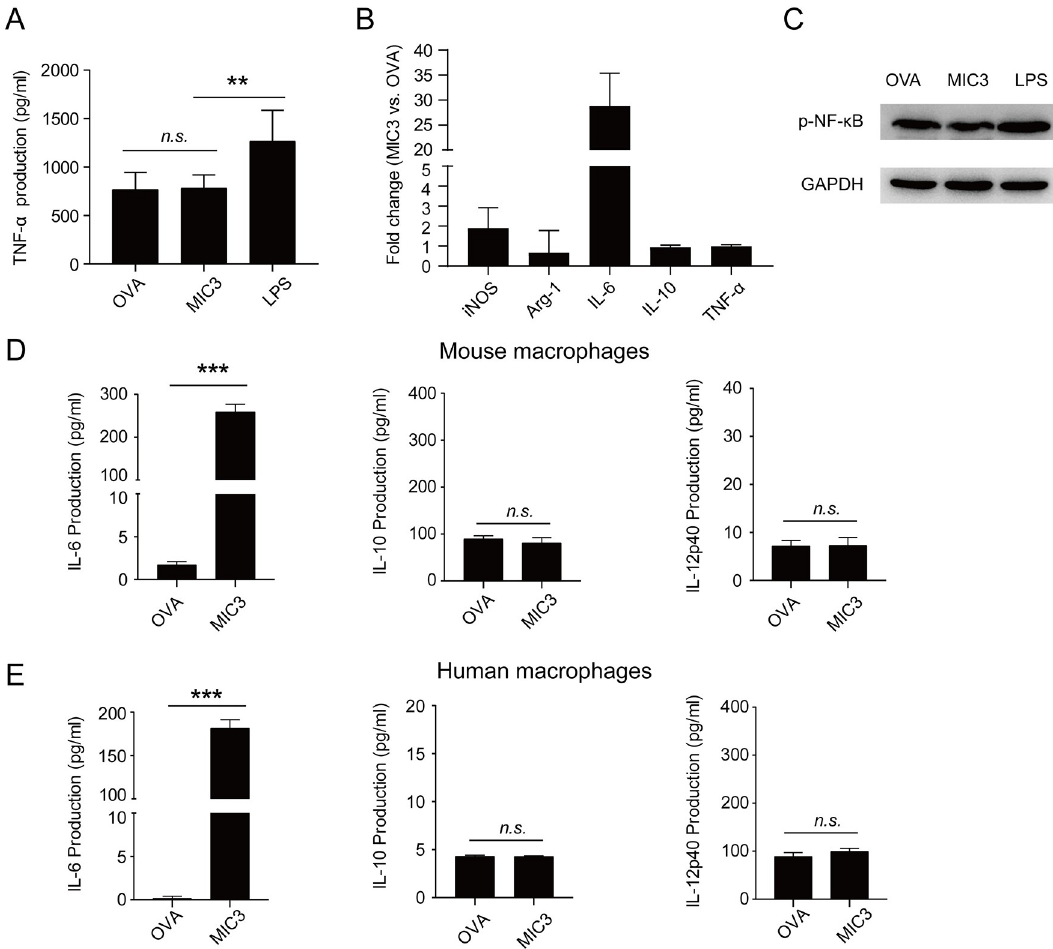
Fig 6. MIC3-induced innate immune responses in THP-1 derived macrophages and cytokine responses in RAW264.7 cells. (A) The levels of TNF- α secreted by THP-1 derived macrophages after 24 h-treatment of MIC3. THP-1 cells were incubated with PMA to differentiate into THP-1 derived macrophages. Then 4 μ g/ml OVA, 4 μ g/ml MIC3 and 1 μ g/ml LPS were added into the culture medium respectively. The levels of TNF- α were evaluated by ELISA. Data are expressed as the means ± S.D. of six independent samples for each group. Significance was determined by one-way ANOVA. �� , P < 0.01. n . s ., P > 0.05. (B) The mRNA levels of polarization and inflammation-related genes after 24 h-treatment of MIC3 in THP-1 derived macrophages. Data are expressed as the means ± S.D. of three independent samples for each group. (C) NF- κ B p65 phosphorylation of THP-1 derived macrophages after the treatment of MIC3. The NF- κ B p65 phosphorylation of THP-1 derived macrophages after 24 h-treatment of 4 μ g/ml MIC3, 4 μ g/ml OVA and 1 μ g/ml LPS was detected by Western blotting. (D) Cytokines secreted by mouse RAW264.7 cells after the treatment with MIC3. The levels of IL-6, IL-10 and IL-12p40 secreted by RAW264.7 cells after 24 h-treatment of 4 μ g/ml MIC3 and OVA were detected by ELISA. Data for IL-6 and IL-12p40 are expressed as the means ± S.D. (n = 3 independent experiments). Data for IL-10 are expressed as the means ± S.D. (n = 4 independent experiments). Significance was determined by the two-tailed Student’s t -test. ��� , P < 0.001. n . s ., P > 0.05. (E) Cytokines secreted by THP-1 derived macrophages after the treatment with MIC3. The levels of IL-6, IL- 10 and IL-12p40 secreted by THP-1 derived macrophages after 24 h-treatment of 4 μ g/ml MIC3 and OVA were detected by ELISA. Data are expressed as the means ± S.D. (n = 4 independent experiments). Significance was determined by the two-tailed Student’s t - test. ��� , P < 0.001. n . s ., P > 0.05.